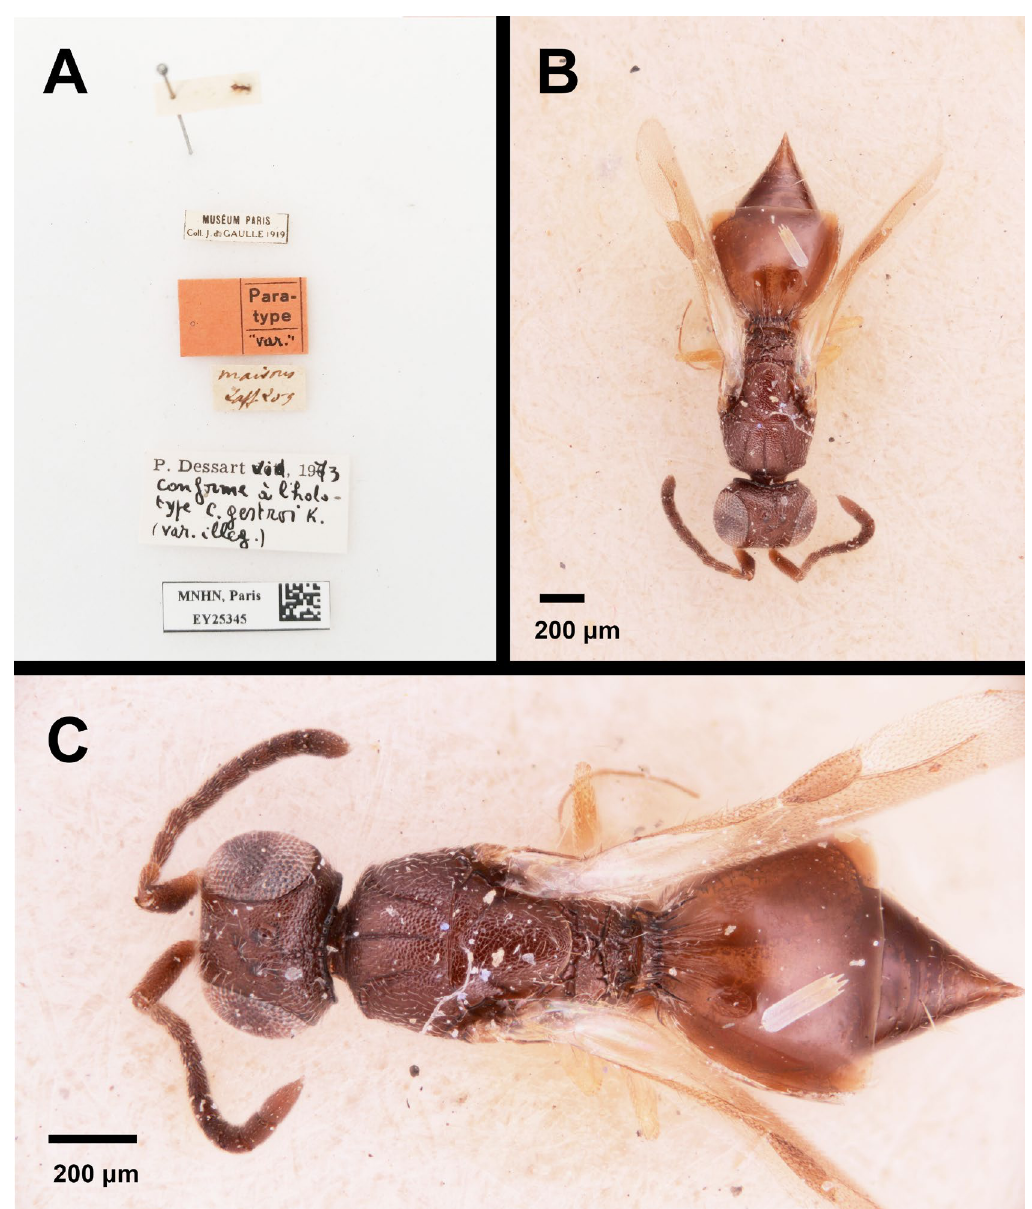
Fig. 28. Constigmus gestroi kieffer, 1907, female variety (MNhN EY25345). A . The labels with the specimen, including Dessart’s label considering it a “var. illeg.”. B . Dorsal habitus. C . A closer dorsal